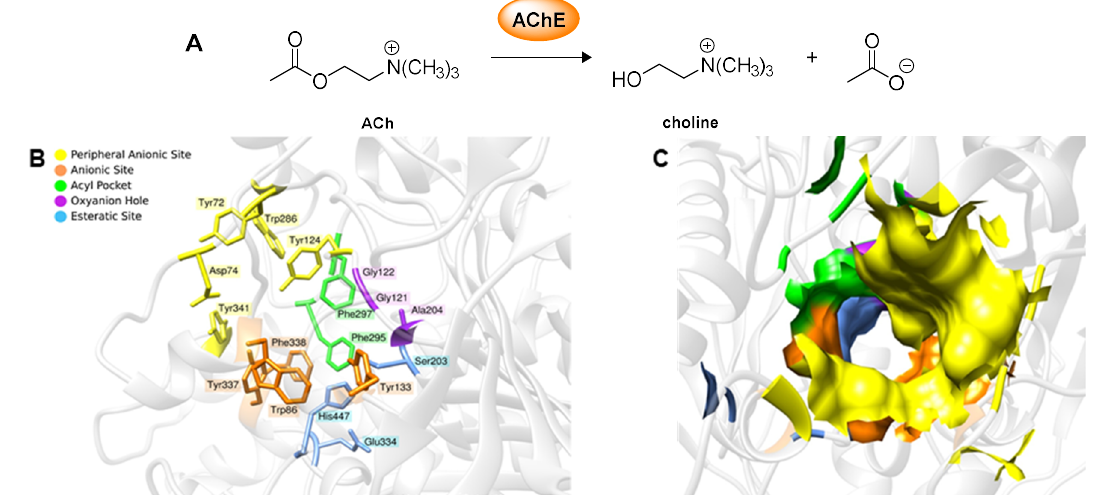
Figure 1. ( A ) Hydrolysis of acetylcholine (ACh) to choline and acetate catalyzed by acetylcholinesterase (AChE). ( B ) View of the h AChE (PDB:4EY4) active site with key amino acid residues color coded by region (reprinted from [3], with permission from Elsevier). ( C ) Surface representation of the h AChE (PDB:4EY4) active site looking down the gorge with regions color coded as in ( B ) (reprinted from [3], with permission from Elsevier).